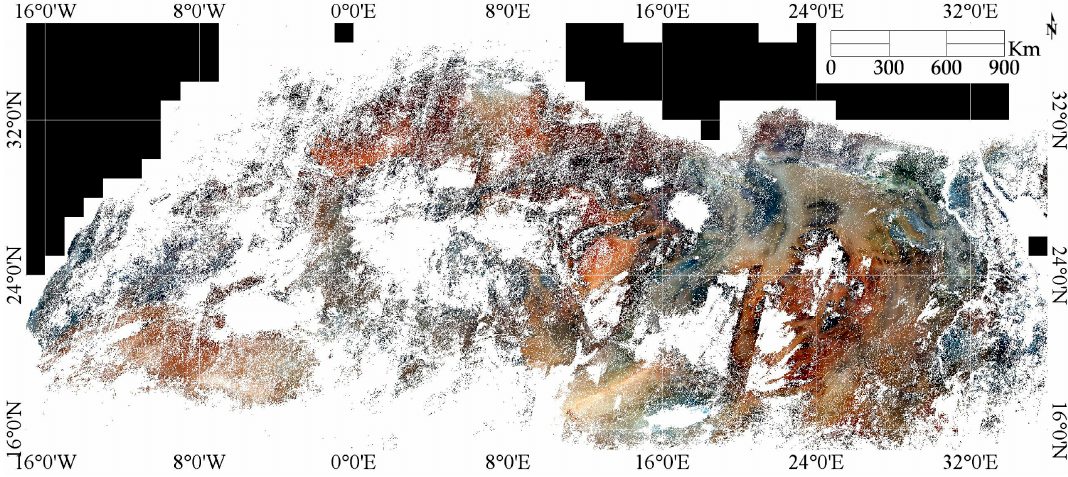
Figure 2. North Africa Mosaic After Filtering Temporally Unstable Pixels.